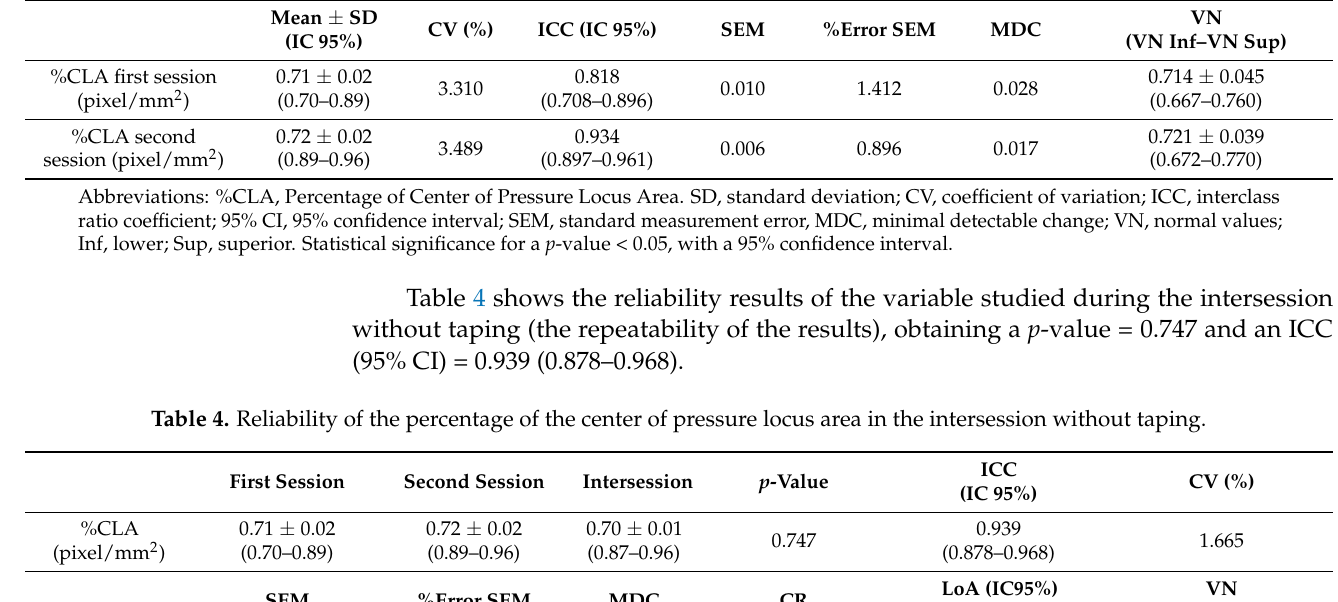
Table 3. Reliability of the variable percentage of the pressure center area without taping in the first and second sessions. Mean ± SD (IC 95%)